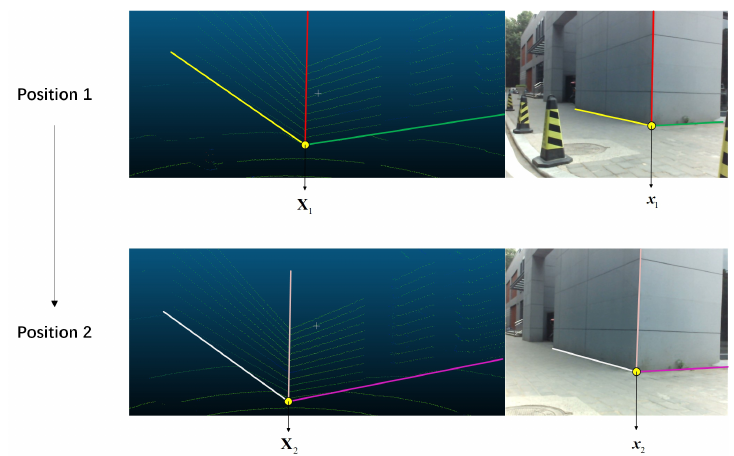
Figure 7. Two datasets from different positions. The lines marked with the same color